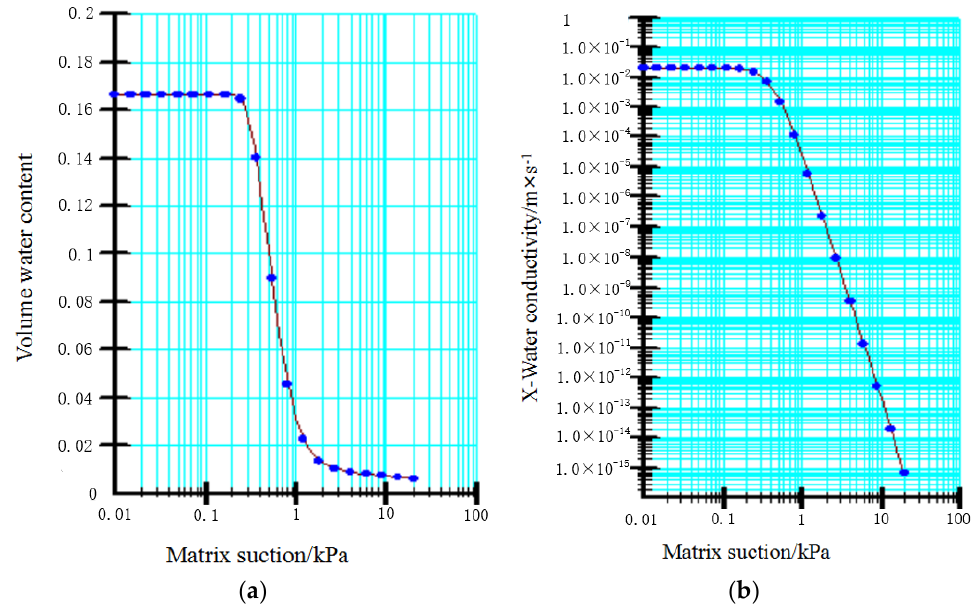
Figure 15. Material parameter settings: ( a ) Volumetric water content function; ( b ) Hydraulic conductivity function.